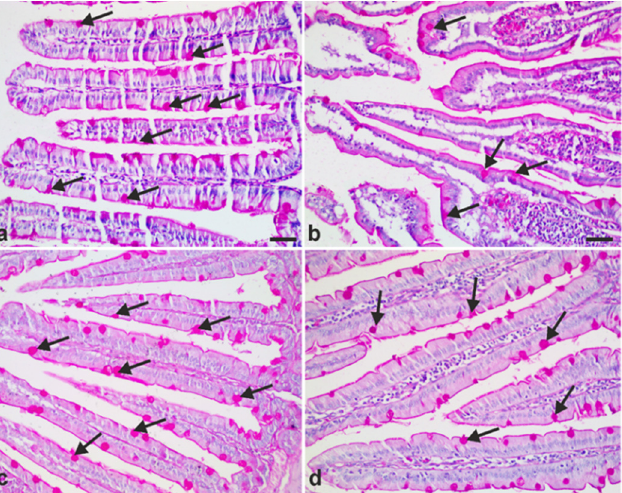
Figure 7. Representative photomicrographs of small intestinal tissues of different groups of hamsters stained with Periodic Acid Schiff (PAS) and hematoxylin to demonstrate goblet cells. ( a ) Representative tissue from uninfected animals showing intestinal villi with goblet cells scattered between epithelia cells. ( b ) Representative tissue from infected untreated animals showing depletion of goblet cells. ( c ) Representative tissue from infected animals treated with metronidazole showing restored goblet cells. ( d ) Representative tissue from infected animals treated with A. annua with restored goblet cells. Scale bar = 50 µm.